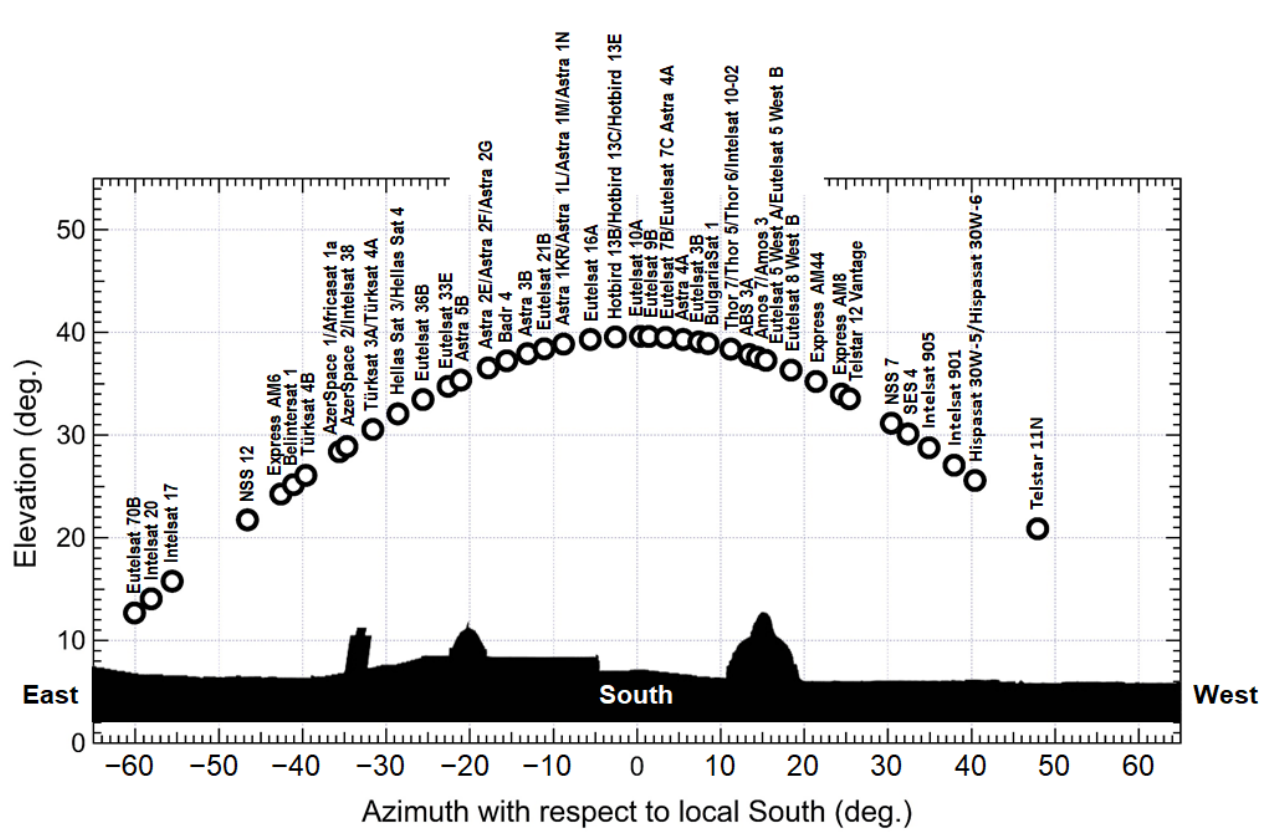
Figure 2. Geostationary satellite arc in the sky of Pisa, Italy (10.4147° E, 43.7117° N).